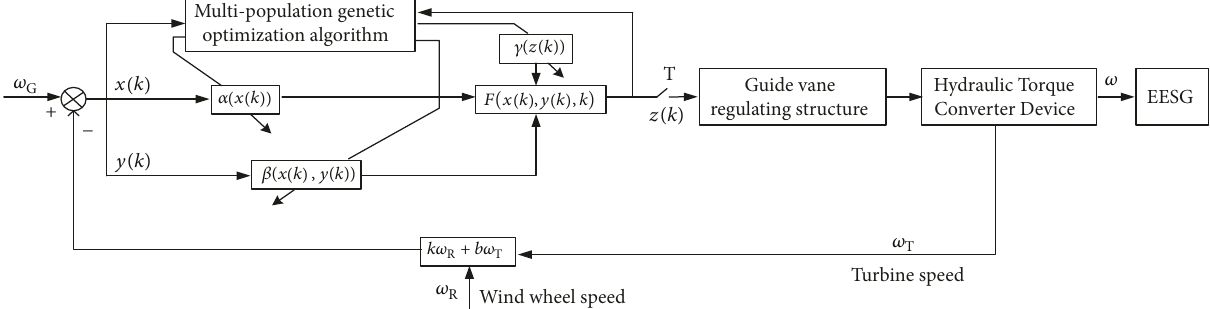
Figure 5: Diagram of variable-universe adaptive fuzzy control system based on MPGA.